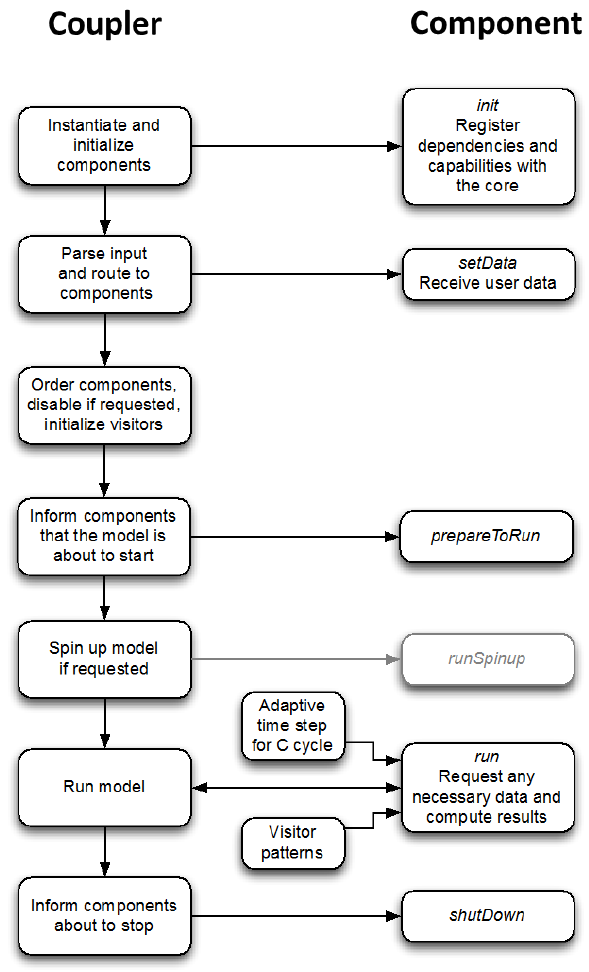
Figure 1. Model phases for the coupler (left) and a typical com- ponent (right). Arrows show flow of control and data. The greyed spinup step is